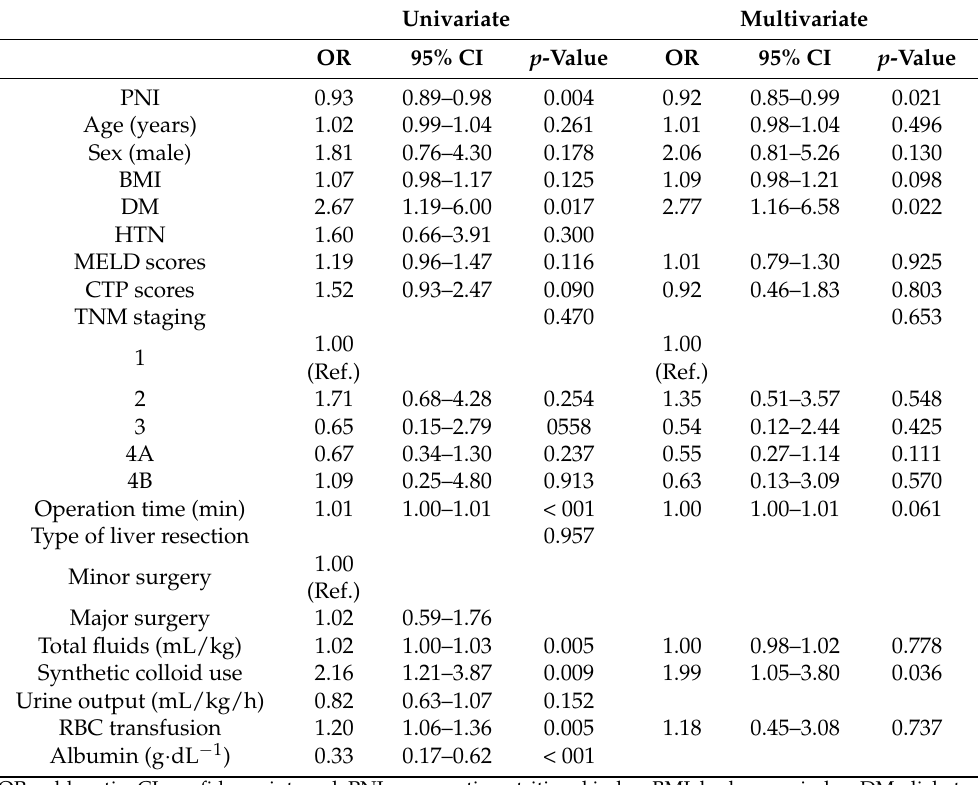
Table 2. Univariate and multivariate logistic regression analyses of acute kidney